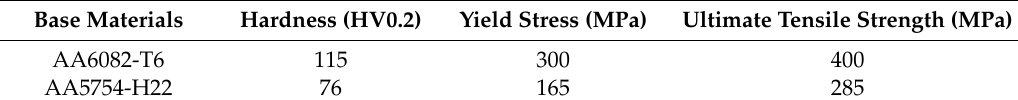
Table 1. Room temperature mechanical properties of the base materials.